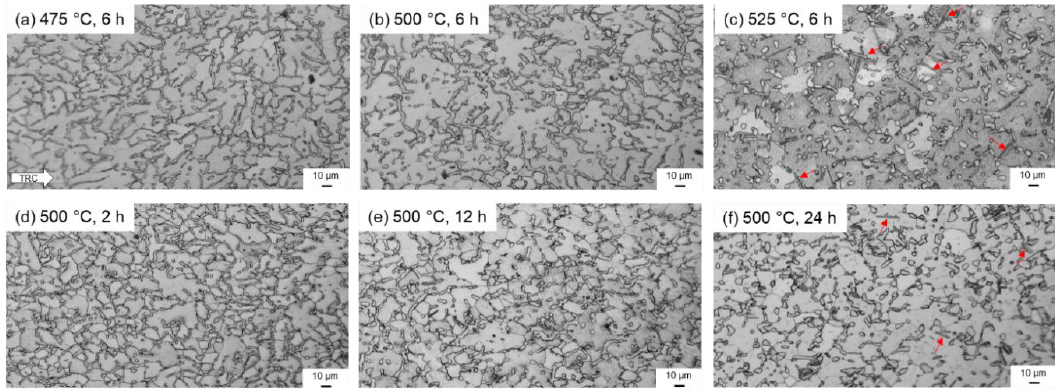
Figure 3. Optical micrographs of the WZ73 TRC sheets after annealing at different temperatures and holding times, with the comparison exemplified by the microstructure from the upper area of the strip cross section (red arrows: LPSO phase with a rod-like shape): ( a ) 475 °C, 6 h, ( b ) 500 °C, 6 h, ( c ) 525 °C, 6 h, ( d ) 500 °C, 2 h, ( e ) 500 °C, 12 h and ( f ) 500 °C, 24 h.